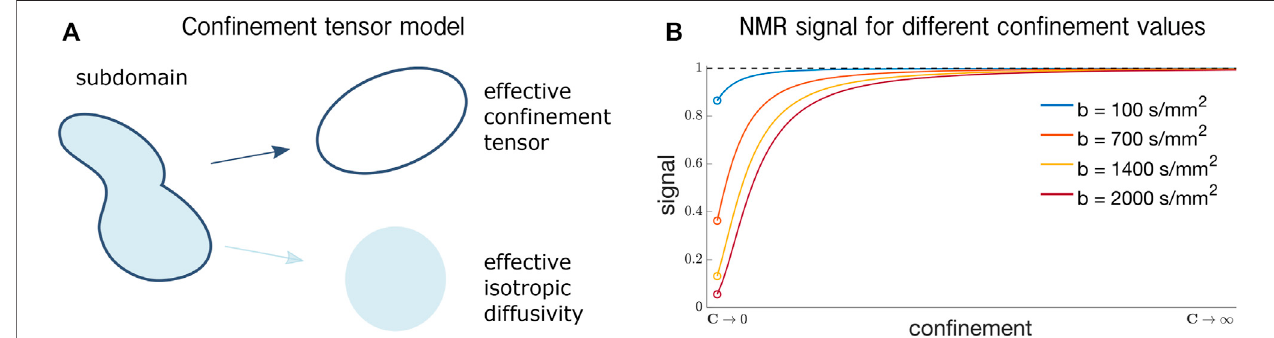
FIGURE1|(A) Con fi nement tensormodel parameters.Forasubdomainofgenericshape, thegeometry iscaptured bytheeffective con fi nementtensor, while the water diffusivity within is represented by an effective isotropic diffusivity. The tensor representing the shape is a second order tensor, while the effective diffusivity is a scalar. (B) Signalfordifferentcon fi nementvaluesforlineartensorencodingexperimentsatdifferentb-values.For C → 0thesignalconvergestothefreediffusionregime, wherethevalueisdeterminedasexp( − bD 0 ),with b beingtheb-value[33].Thisisrepresentedbythecoloredcirclesintheplot.For C → ∞ ,thesignalconvergesto 1 indicating complete water